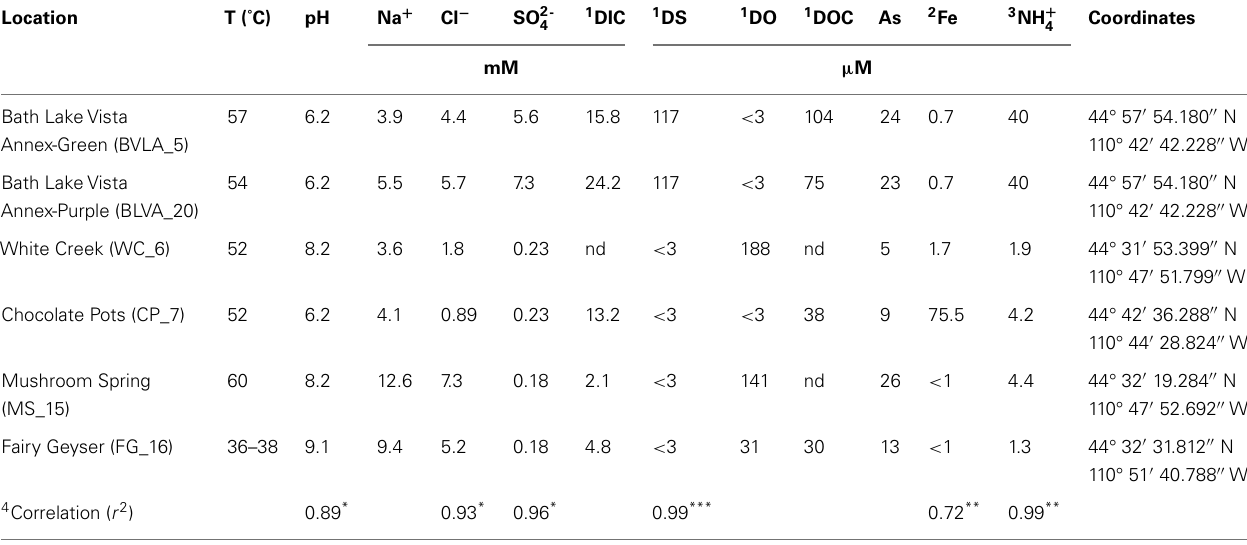
Table 1 | Sample locations and aqueous geochemical parameters 1 of six, high-temperature phototrophic microbial communities sampled in Yellowstone National Park (YNP) and used for metagenome